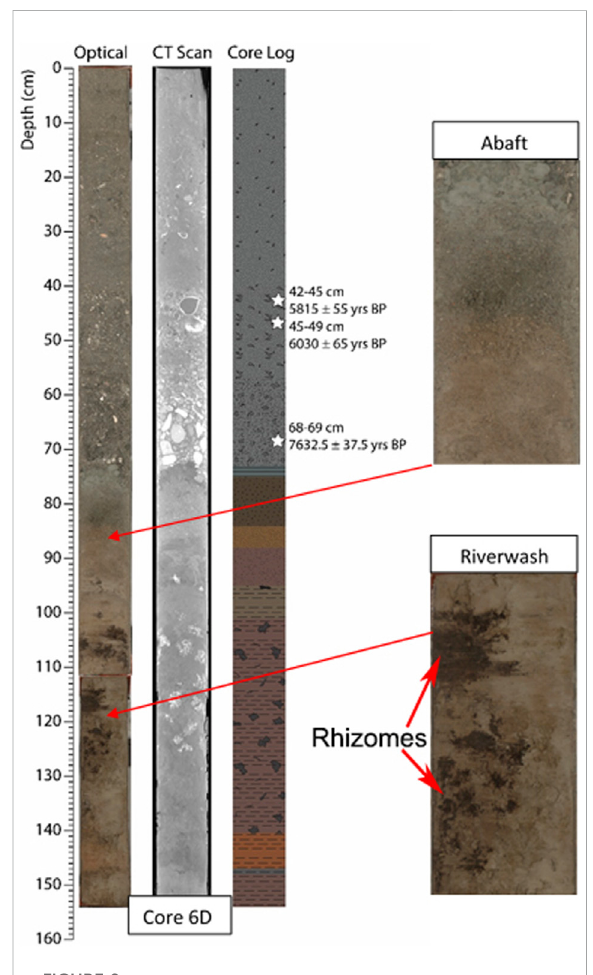
FIGURE 9 Optical,CT,andcorelogimagesofCore6Dwithphotograph insets of Riverwash (Fluvent) and Abaft (Psamment) paleosols. White star on core log shows location of radiocarbon sample and depth and age are noted. Red arrow shows location of paleosol. Rhizomes features are noted in the